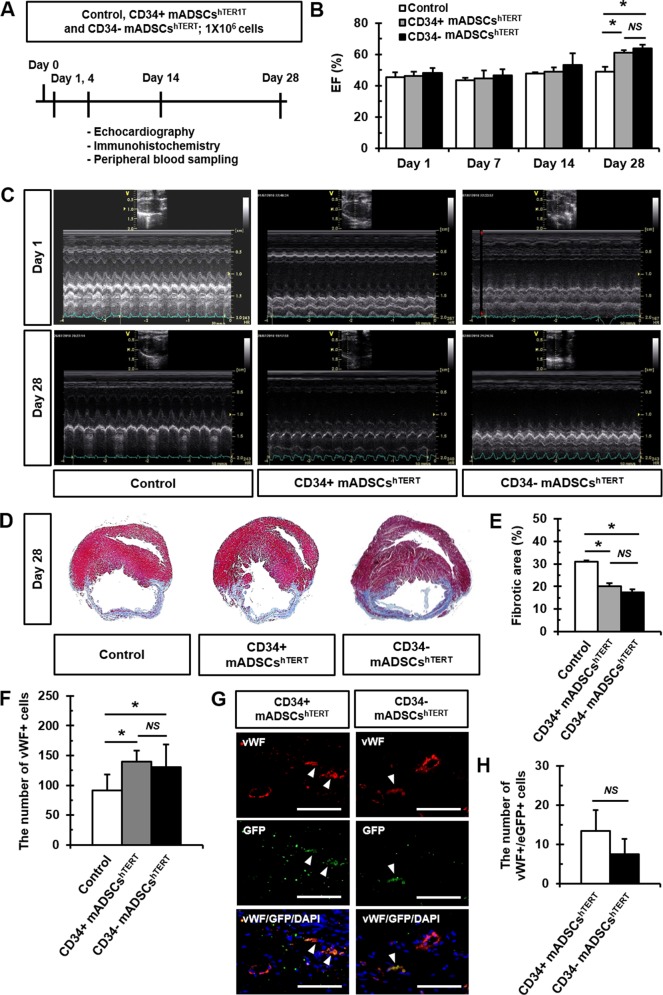
Transplantation of CD34+ and CD34- mADSCshTERT into a rat AMI model improved cardiac function and reduced fibrosis partly via endothelial differentiation.(A) Schematic diagram of the study protocol. 1 × 106 CD34+ and CD34- mADSCshTERT were transplanted into the peri-infarct region of a rat AMI model. Echocardiography was performed at 1, 7, 14, and 28 days after cell transplantation. (B) LVEF was significantly improved in CD34+ and CD34- mADSCshTERT groups at day 28 after transplantation. Data shown represent mean ± SD (n = 10, *p < 0.05; NS, not significant). (C) Representative images of 2D echocardiography demonstrating improved LVEF in CD34+ and CD34- mADSCshTERT groups at day 28 after transplantation. (D) Representative Masson’s trichrome-stained images showing reduced fibrotic areas in CD34+ and CD34- mADSCshTERT groups at day 28 after transplantation. (E) Myocardial fibrosis was quantified at day 28 after cell transplantation. Data shown represent mean ± SD (n = 10, *p < 0.05, **p < 0.01; NS, not significant). (F) The number of vWF+ cells in the infarcted hearts of CD34+ and CD34- mADSCshTERT injected rats was quantified using Image-Pro 7.0 software at day 28 after cell transplantation. Data shown represent mean ± SD (NS, not significant) on 20 sections. (G) Representative images showing GFP+ (green)/vWF+ (red) cells (arrowheads) in blood vessels of the infarcted hearts of CD34+ and CD34- mADSCshTERT injected rats at day 28 after cell transplantation. (H) The number of GFP+/vWF+ cells in the infarcted hearts of CD34+ and CD34- mADSCshTERT injected rats was quantified using Image-Pro 7.0 software at day 28 after cell transplantation. Data shown represent mean ± SD (NS, not significant) on 20 sections (two fields per section, two sections per heart, n = 5 for each group). Scale bars = 100 μm.